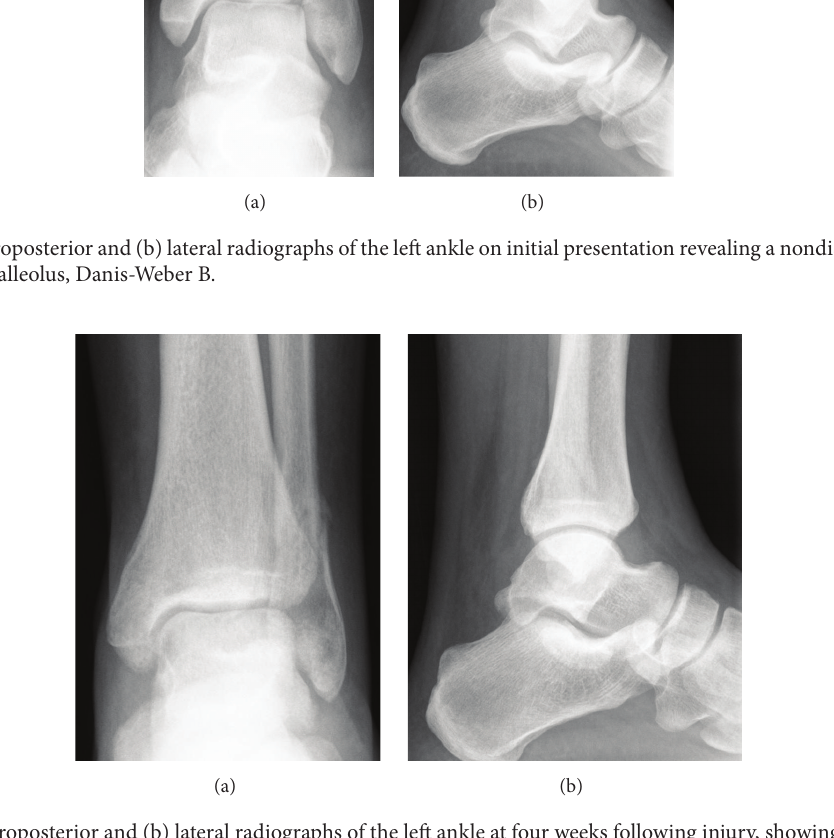
Figure 2: Plain (a) anteroposterior and (b) lateral radiographs of the left ankle at four weeks following injury, showing good alignment with callus formation at the fracture